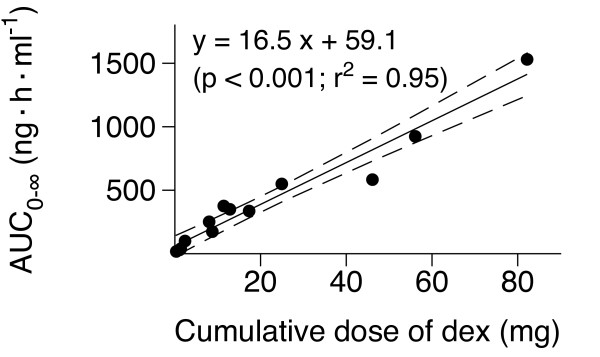
Relation of the total dexmedetomidine dose and the area under the dexmedetomidine concentration-time curve extrapolated to infinity (AUC). The dashed lines represent the 95% confidence intervals for the regression line (solid line).